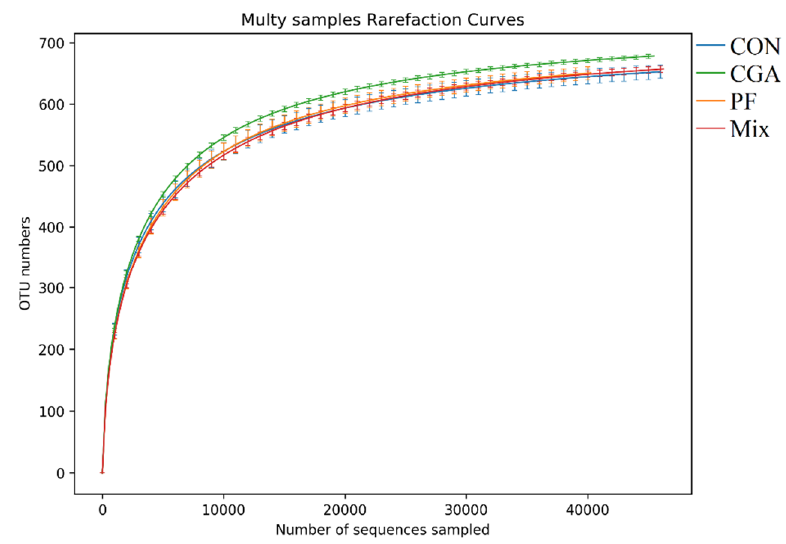
Figure 1. Rarefaction curves. The horizontal coordinate is the number of randomly selected sequenc- ing strips, and the vertical coordinate is the number of features obtained based on the number of sequencing strips. Each curve represents one sample, marked with different colors.